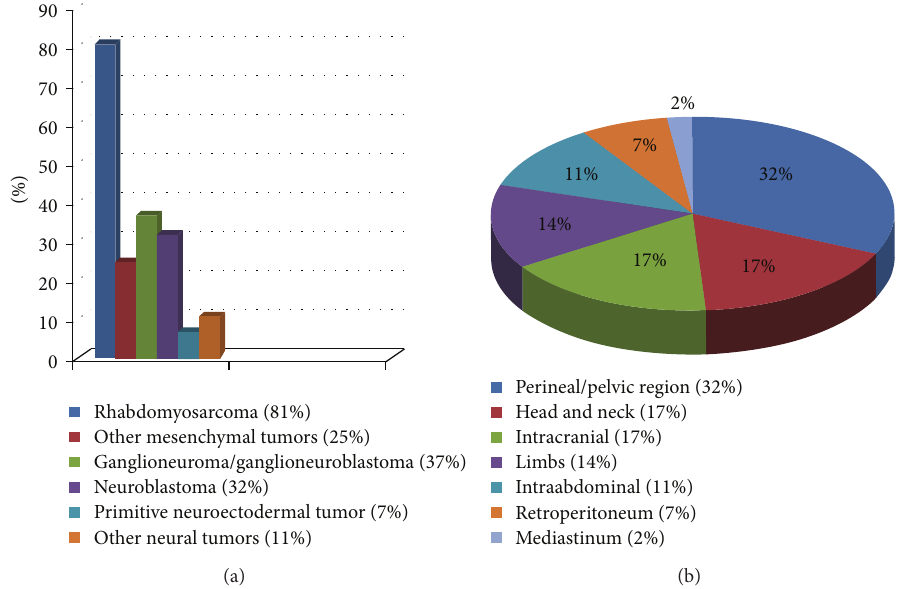
Figure 7: Charts to show (a) histological features and (b) primary anatomical sites of involvement of malignant